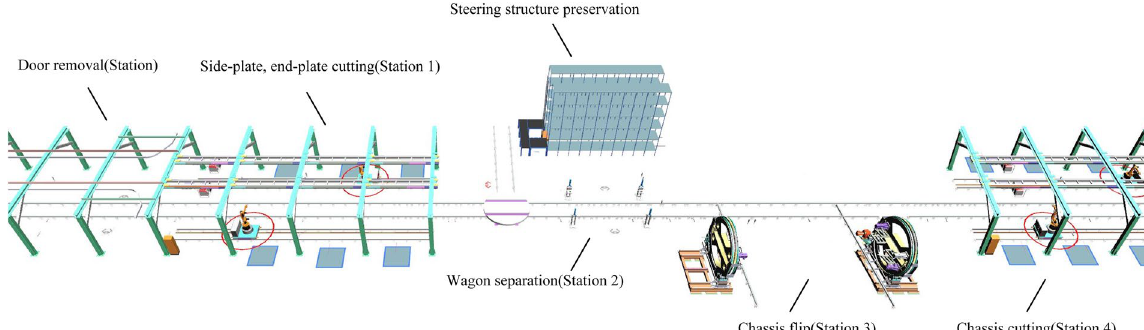
Fig. 2 Wagon dismantling system 3D model diagram